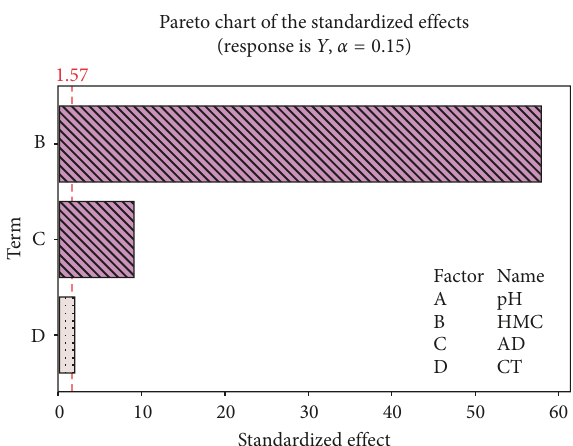
Figure 2: The Pareto chart of standardized effects drawn after response transformation. Effectual factors impacting the removal capacity of BPP exceed the reference